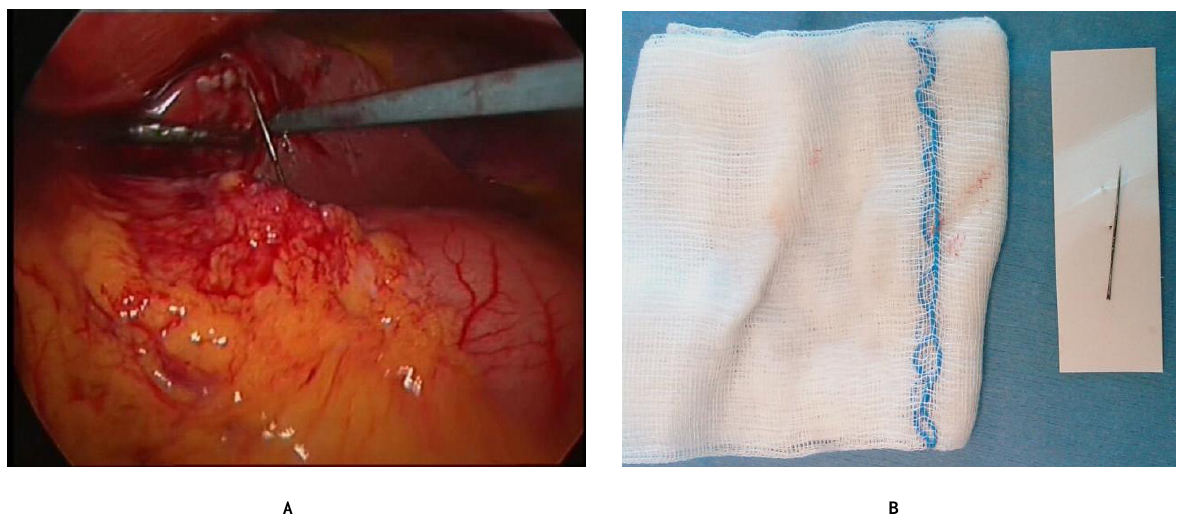
FIGURE 3. (A) Laparoscopic imaging showing the perforating sewing needle. (B) Postoperative image of the removed sewing needle, lying beside a 10-  10-cm